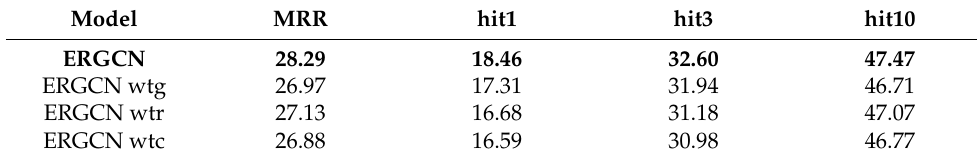
Table 5. Ablation studies on